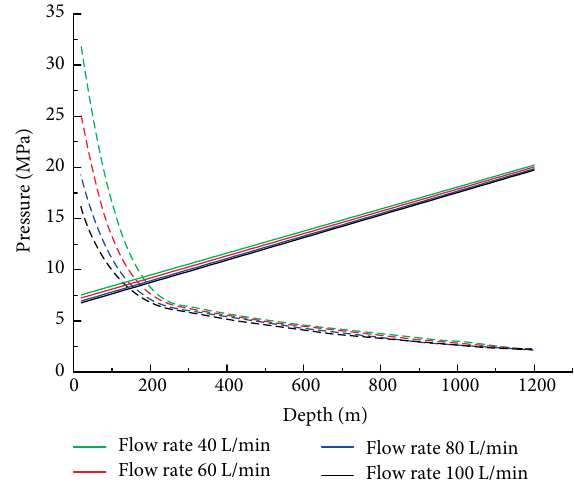
Figure 4: The annulus pressure distribution and hydrates phase equilibrium with different injection rates.